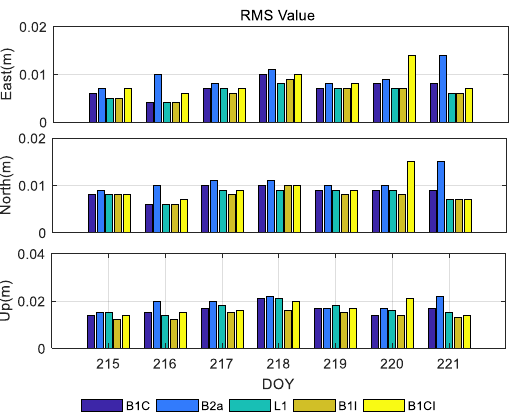
Figure 3. BORJ–TGBF (6 km) single frequency short baseline RTK positioning accuracy. Figure 3. BORJ – TGBF (6 km) single frequency short baseline RTK positioning accuracy. Table 4. BORJ – TGBF (6 km) average of short baseline RTK RMS and ambiguity fixing rate. Table 4. BORJ–TGBF (6 km) average of short baseline RTK RMS and ambiguity fixing rate. Frequency